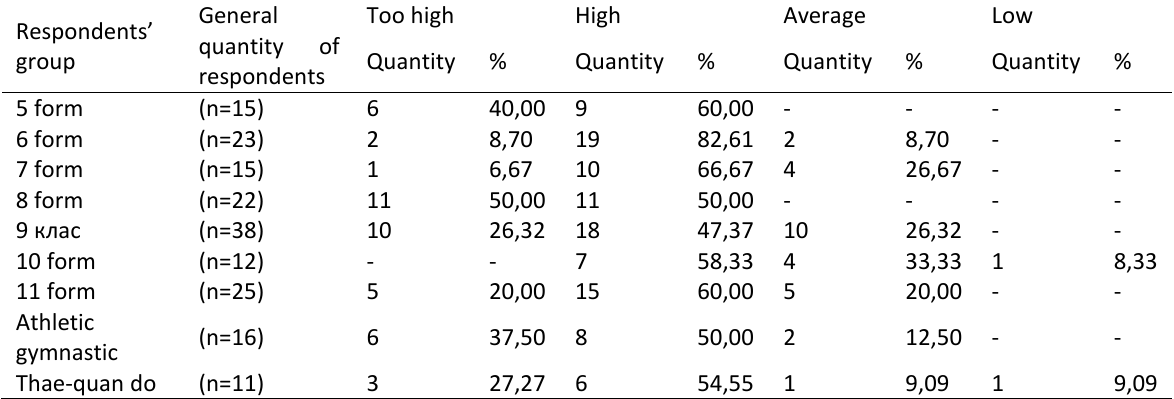
Table 2. General self assessment of physical condition (boys)